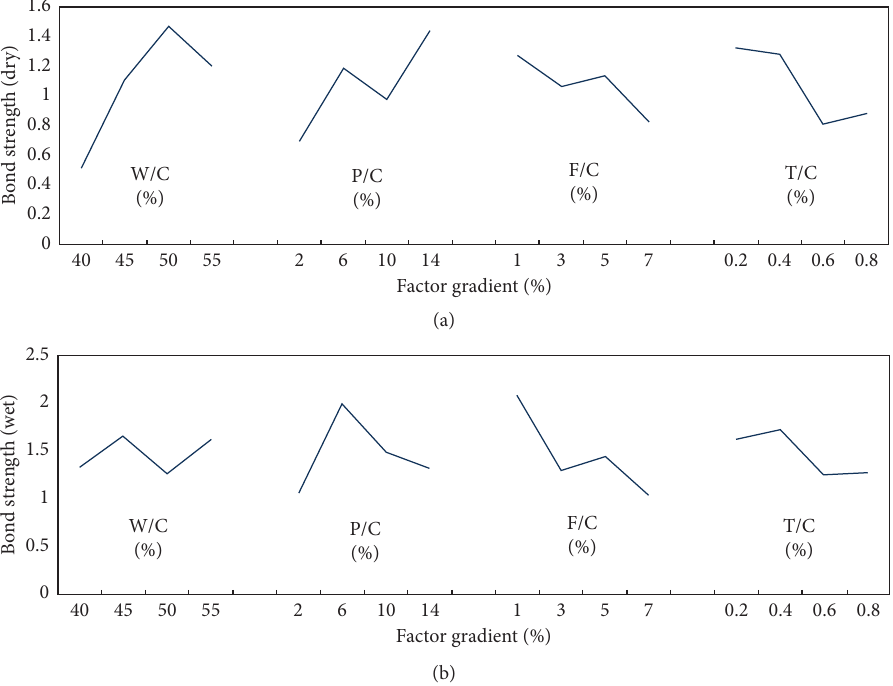
Figure 13: Influence factor map. (a) Bond strength factor influence diagram (dry wall). (b) Bond strength factor influence diagram (wet